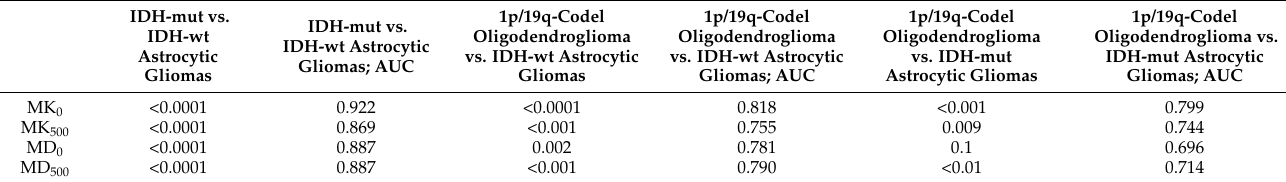
Table 6. Statistical differences ( p -values) and AUC from ROC analysis of the three glioma subgroups for MK and MD evaluation: AUC, area under the curve; ROC, receiver operation characteristic; MK, mean kurtosis; MD, mean diffusivity. IDH-mut vs.